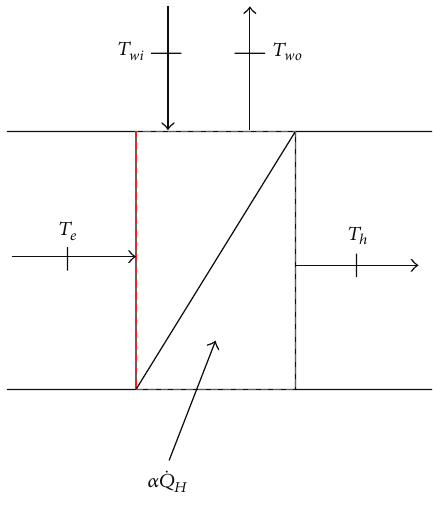
Figure 5: Schematic controlled volume of heating coil model.